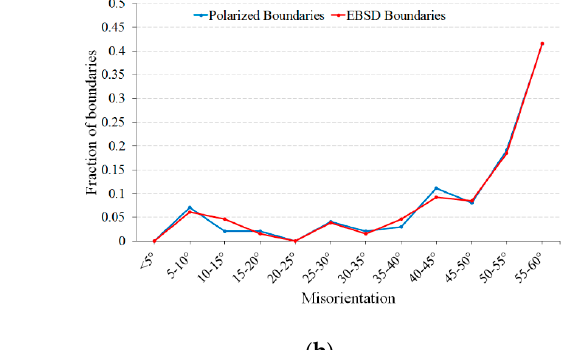
( b ) Figure 9. Number of identified boundaries ( a ) and fraction of boundaries ( b ) based on the misorientation angles, as-cast EMS billets, sand mold billets. When reviewing the results of grain boundary identification through color metallography and EBSD, whilst the end results were comparable, the time spent acquiring the data was significantly different. As explored in Table 1, the total time to analyze a single region with color metallography was 100 min faster than through EBSD analysis. The higher testing time associated with EBSD can be linked to the longer sample preparation time required to develop high quality scans as well as the upwards of 75 min required to produce a scan. Samples can be anodized and then analyzed through optical microscopy in as little as 20 min hence, for the time it takes to scan and analyze a single EBSD sample, four samples could be anodized and analyzed through color metallography. When comparing the cost of carrying out each technique, polishing costs are higher for EBSD than for color metallography due to the longer polishing times. Whilst this higher polishing cost is somewhat offset by the requirement of an anodizing solution, the capital expenditure and booking fees are significantly higher for an SEM than an optical microscope. 4. Conclusions In order to study the capability of color metallography as a reliable microstructural characterization technique in distinguishing the primary particles, anodizing-polarized light